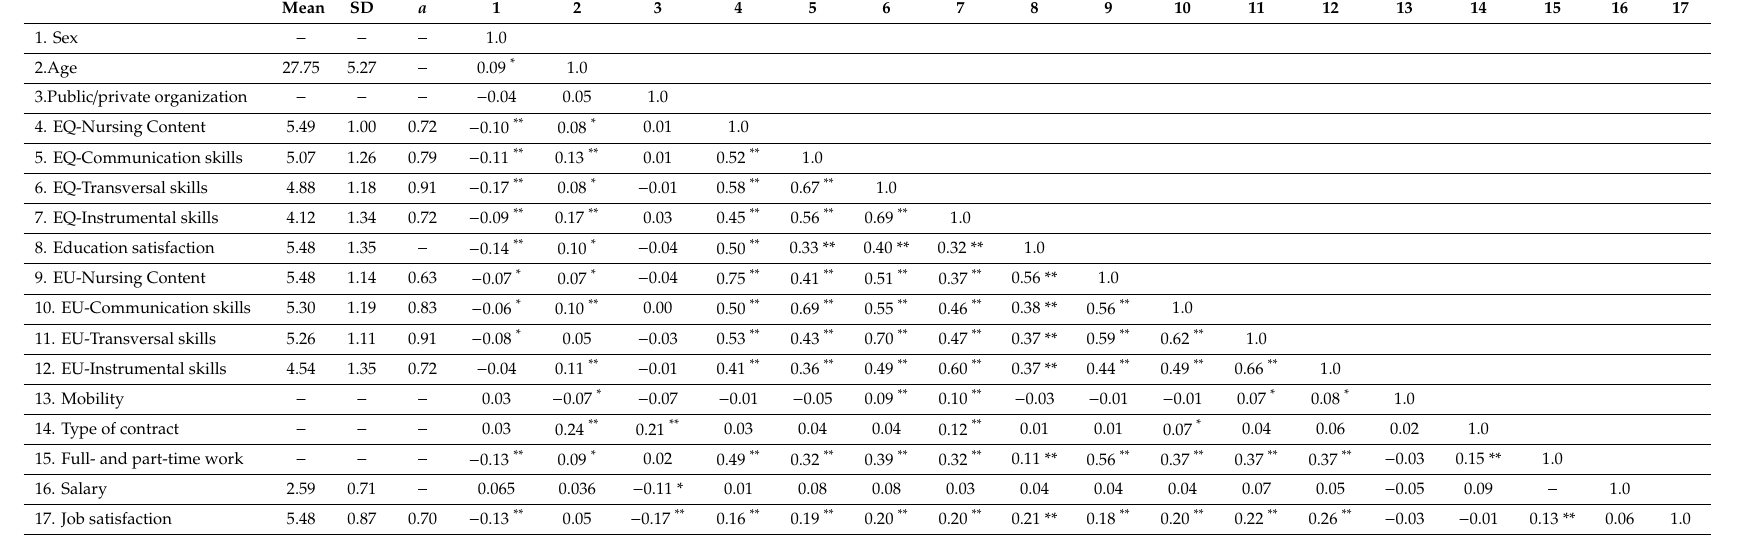
Table 3. Descriptive statistics (means and standard deviations) and